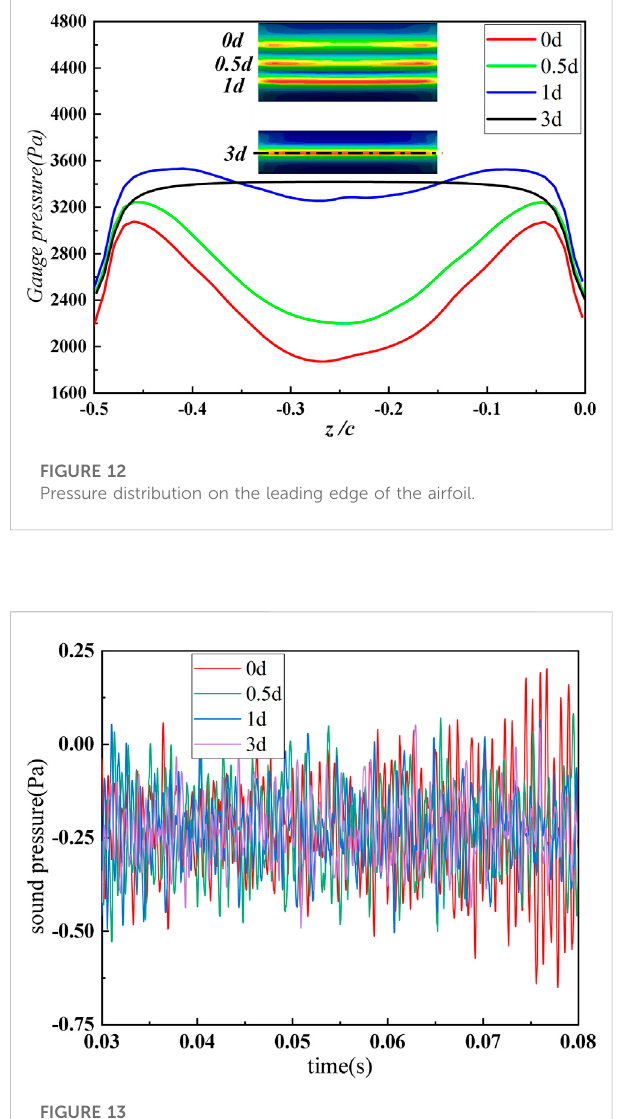
gradually with the increase of offset distance, from 89 dB to 80.6 dB. The peak sound frequency decreased signi fi cantly when the offset distance changed from 0d to 0.5d. Its frequency did not change signi fi cantly when the offset distance changed from 0.5d to 1d and increased slightly from 0.5d to 3d. With the increase of offset distance, the sound pressure level decreases almost linearly from 0d to 1d; From 1d to 3d, the decrease rate slows down signi fi cantly.